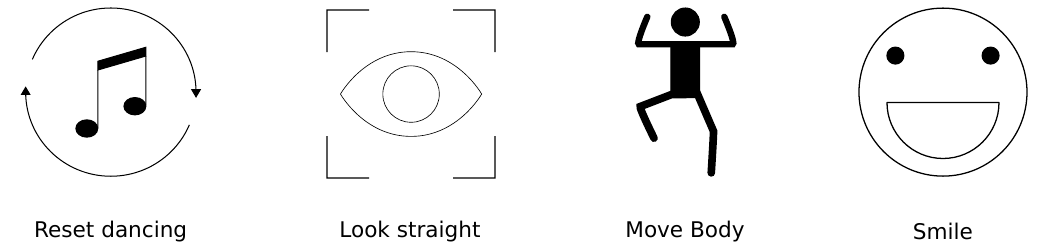
Figure 2. Feedback instructions presented by the Online Feedback